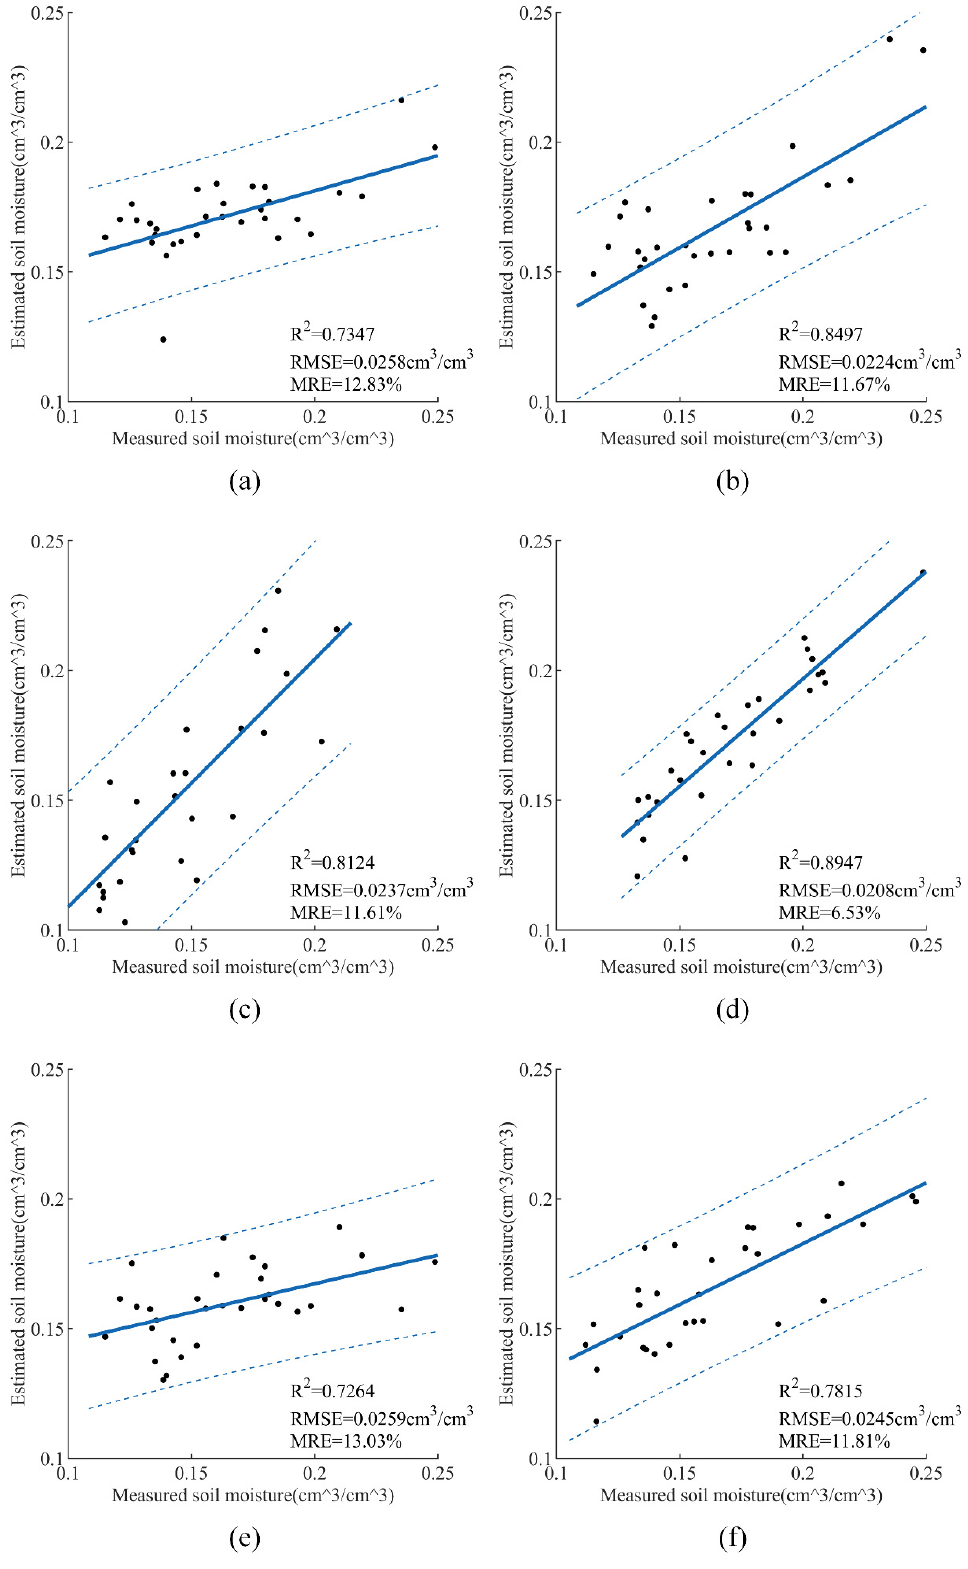
Figure 10. SMC retrieval results of the CNNR model with different feature combinations: ( a ) σ 0 NDVI, ( b ) σ 0 + σ 0 + DEM + LIA + NDVI + H + A + α , ( c ) σ 0 VH VV LIA + MSAVI + H + A + α , ( e ) σ 0 + σ 0 + DEM + LIA + DVI, ( f ) σ 0 VH VV